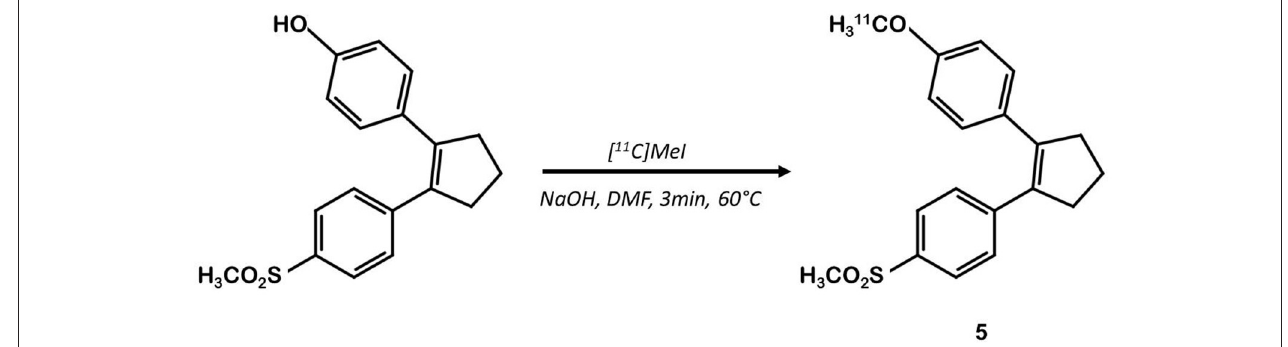
FIGURE 4 | Radiosynthesis of [ 11 C]diarylcyclopentene